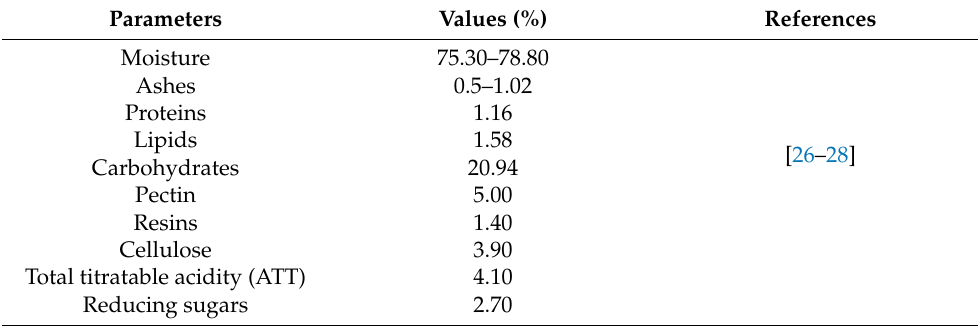
Table 4. Bacuri shell composition ( Platonia insignis